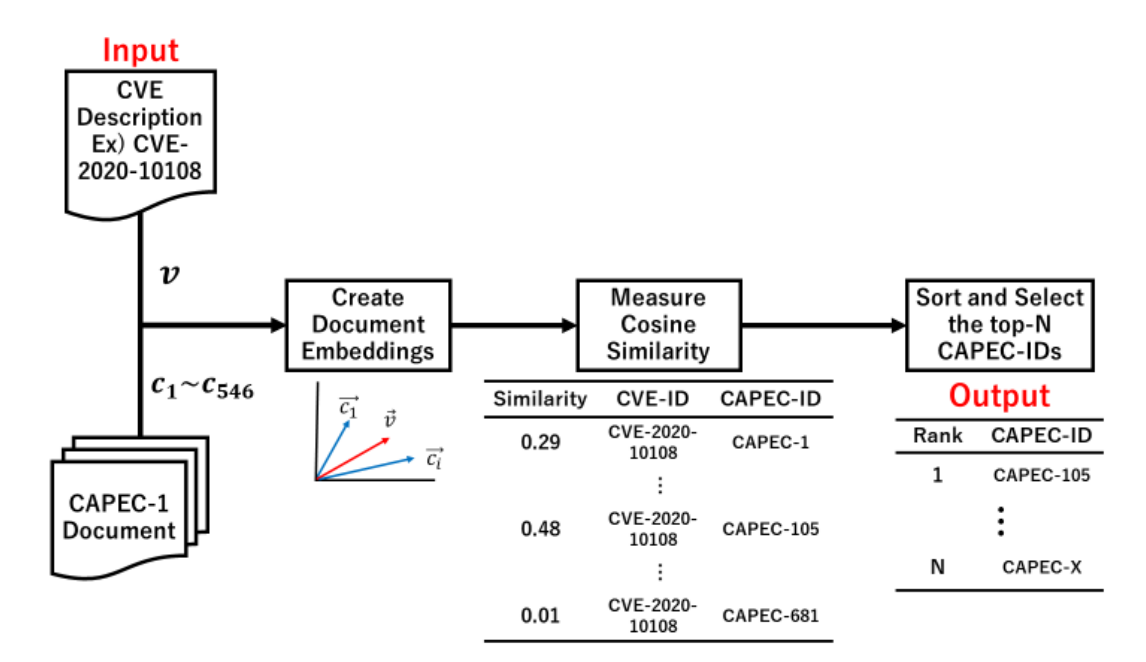
Figure 1. Overview of the proposed approach using the entire document.